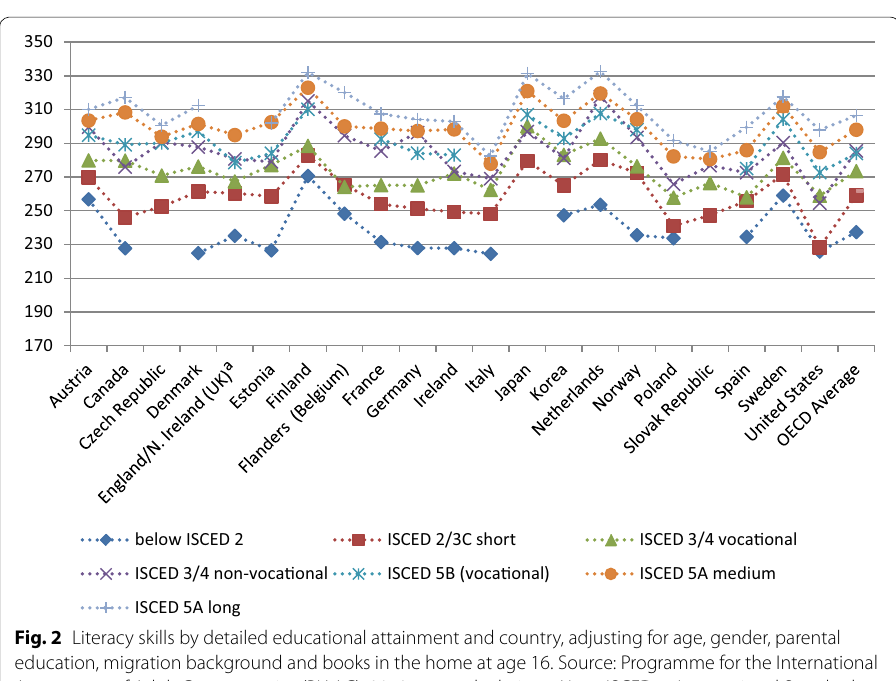
International Standard =